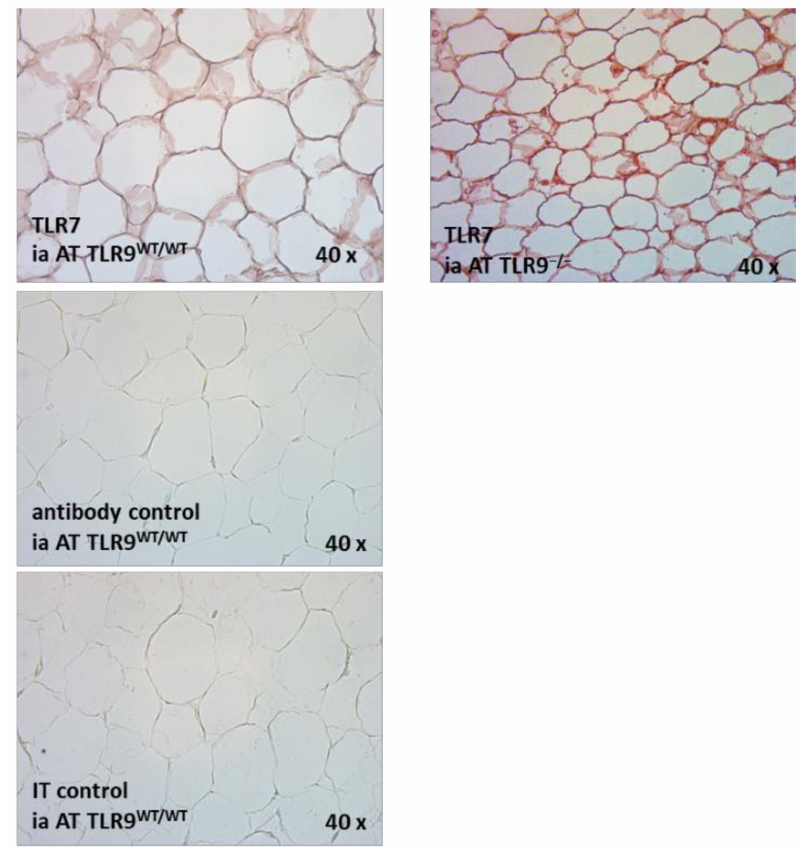
Figure A2. TLR7 protein is expressed in intra-abdominal adipose tissue (AT) in TLR9 wt/wt and in TLR9 − / − mice. TLR7 protein expression was detected and visualized via immunohistochemical methods in intra-abdominal (ia) adipose tissue from TLR9 wt/wt and TLR9 − / − mice (representative sections are shown).